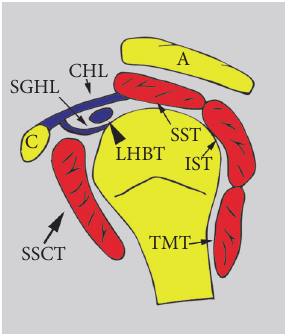
Figure 2: Anatomy of the rotator interval. Sagittal view of the humerus. The supraspinatus tendon (SST) and subscapularis tendon (SSCT) are traversing laterally superior and anterior to the humeral head. The long head of the biceps tendon (LHBT) is anterior to the SSCT after it originates from the superior glenoid. The coracohumeral ligament (CHL) originates from the coracoid process (C) as it extends between the SST and SSCT, abutting the superior glenohumeral ligament (SGHL). The acromion process (A) is also shown. IST � infraspinatus tendon; TMT � teres minor tendon (illustration by Zohaib